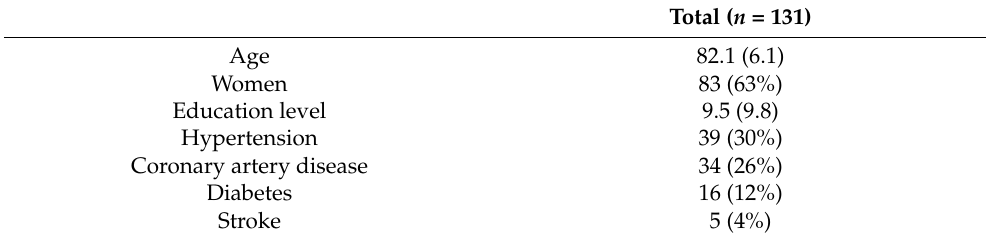
Table 1. Demographic and clinical characteristics of the elderly patients scheduled for